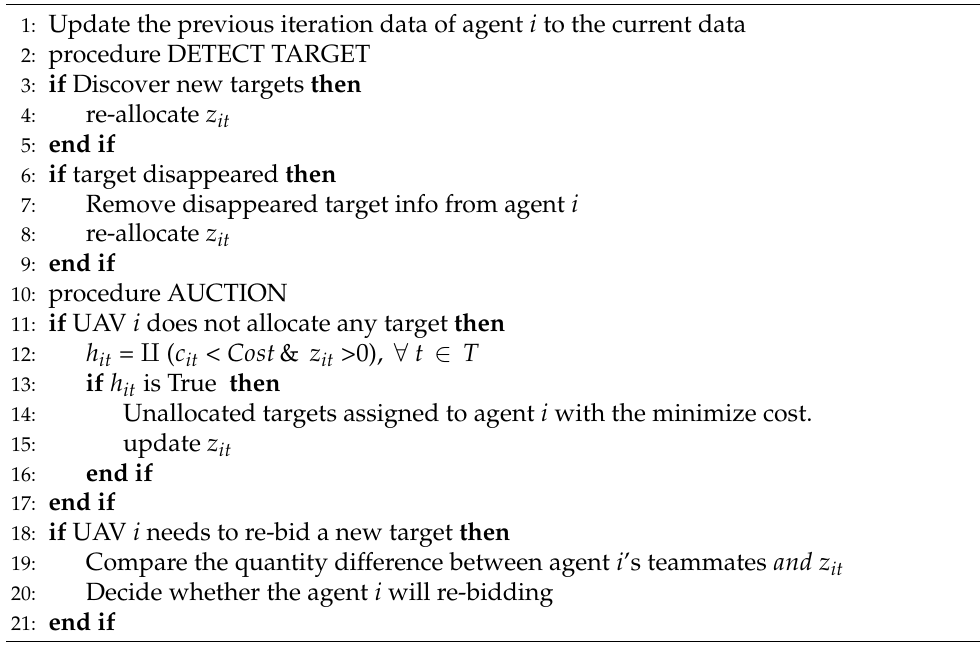
Figure 2. Simulation of scenario when number of targets exceeds the number of agents: ( a ) Initial state: 5 targets and 3 agents, ( b ) Midway state: agents search target and ( c ) Final state: agents arrive at their assigned targets and abandon the farthest targets away from the center of the global gravity. Algorithm 1 C-CBAA Phase 1 for agent i at iteration